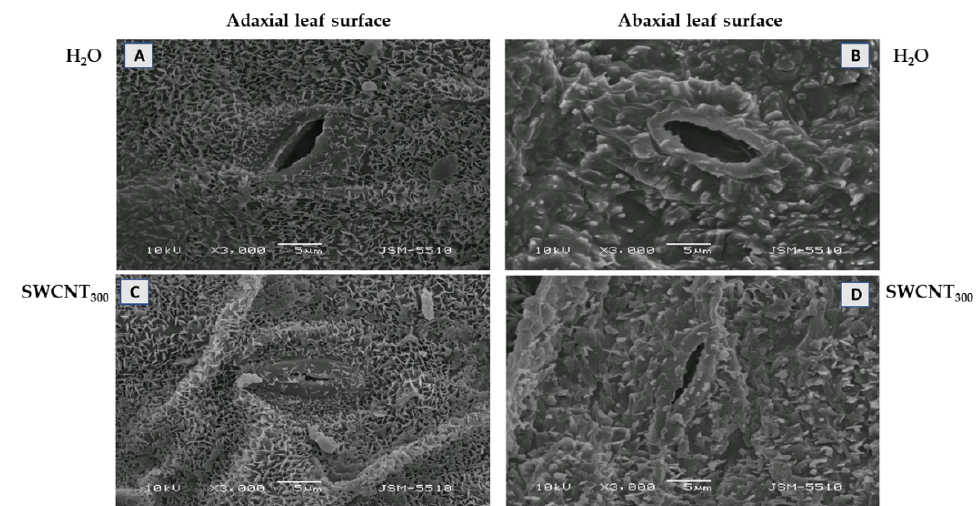
Figure 1. Effect of SWCNTs on leaf micromorphology. Cuticle and epicuticular waxes at the adaxial ( A , C ) and abaxial ( B , D ) leaf surface of pea plants seven days after spraying with H 2 O ( A , B ) and SWCNT 300 ( C , D ).